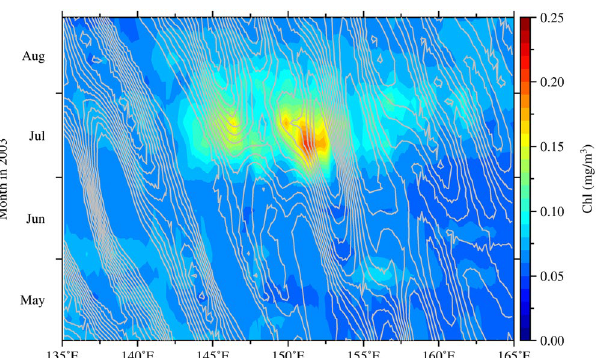
Figure 3. Hovmöller diagram of Chl (color) and positive SSH anomalies (contour interval: 2 cm), averaged within